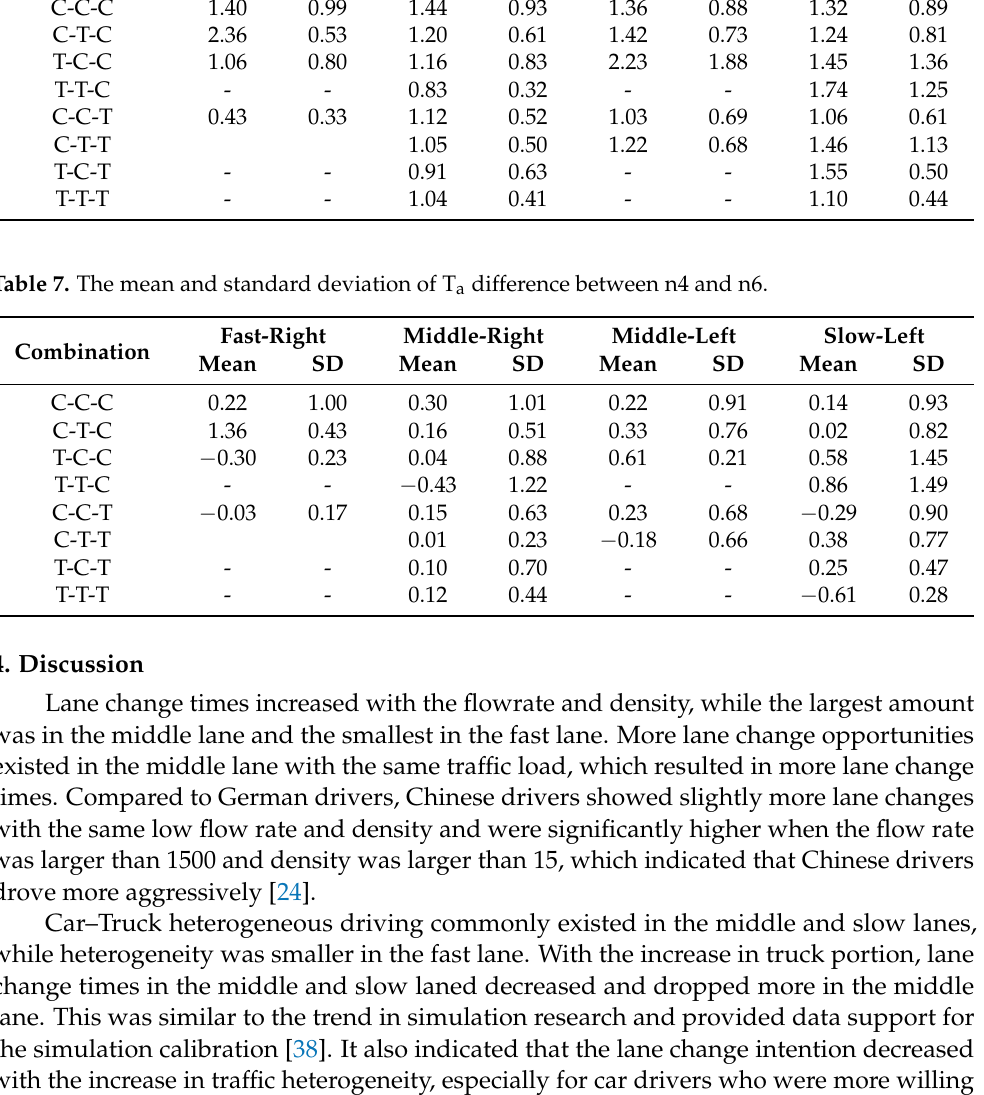
Table 6. The mean and standard deviation of T a of n6. Combination